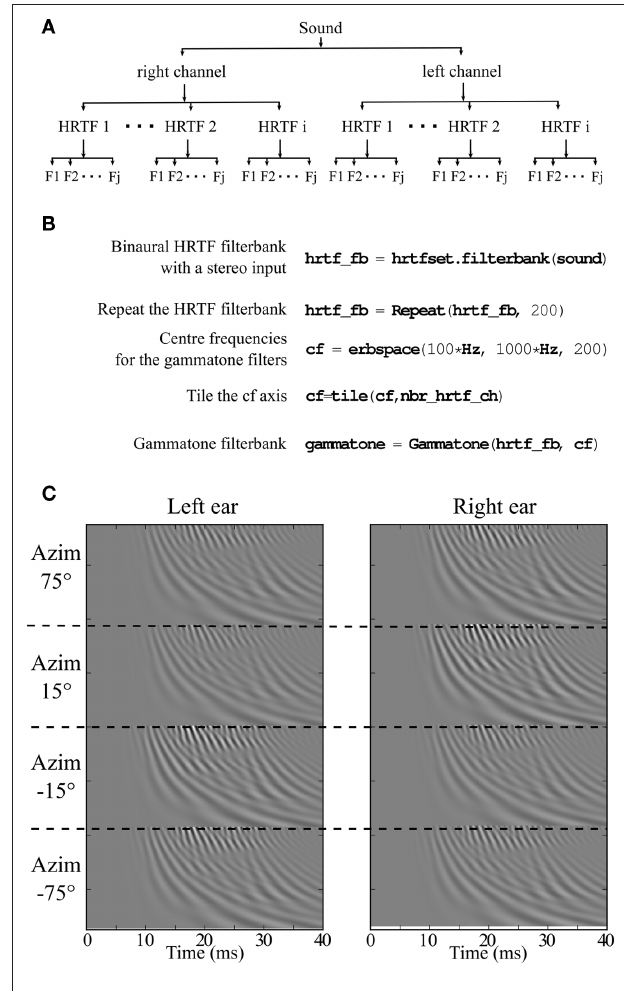
FiGUre 6 | Vectorization over frequency and multiple head related transfer functions (HrTFs). (A) Schematic of nested vectorization over multiple HRTFs and frequencies. (B) Corresponding Python code. (C) Stereo output of the filterbank for four